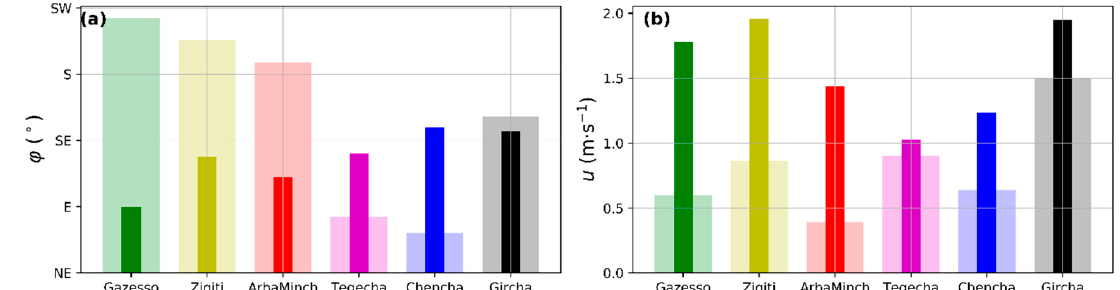
Figure 5. The dominant local wind sources in the GEMS stations network in Feb 2017 during daytime (full-colored bar plots) and nighttime (light-coloured bar plots). The left and right plots show wind direction ( a ) and wind speed ( b ), respectively, as explained in Section 2.3.